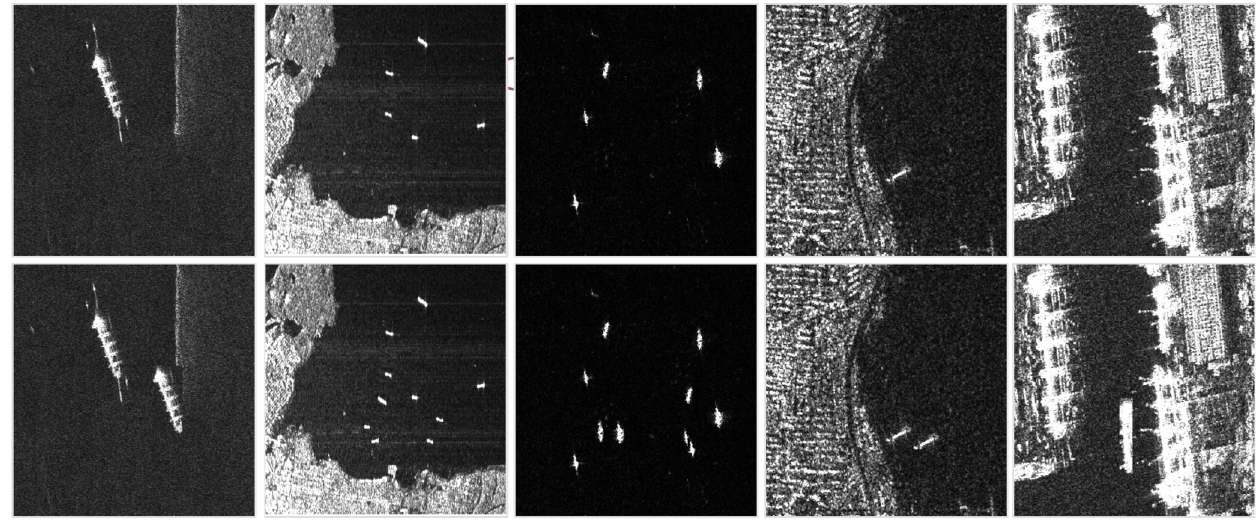
Figure 8. Enhanced renderings. The first row shows the original images and the second row shows the enhanced